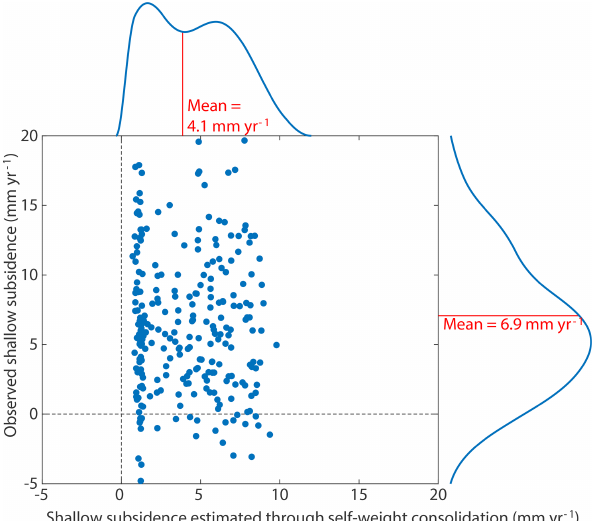
Figure 3. Estimated vs. predicted shallow subsidence based on Eq. (2). Histograms show distribution of predicted and observed rates, including their mean.